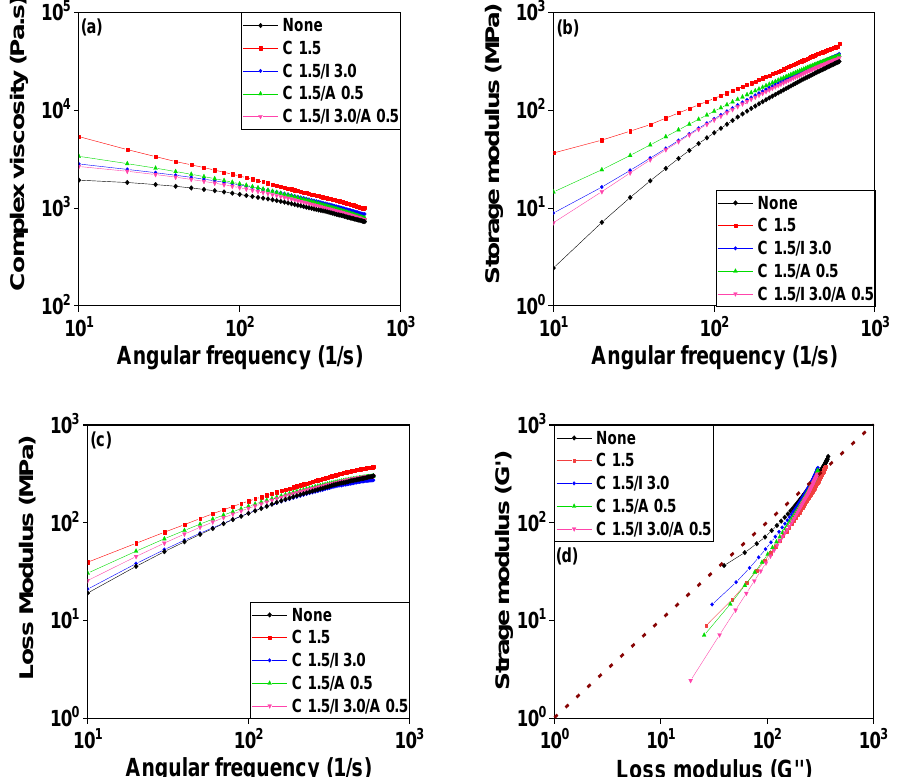
Figure 14. Rheological properties of POM, POM/C1.5, POM/C1.5/I3, POM/C1.5/A0.5, and POM/C1.5/I3/A0.5 nanocomposites: ( a ) complex viscosity; ( b ) shear storage modulus ( G’ ); ( c ) shear loss modulus ( G” ) as a function of frequency; ( d ) G’ vs. G”.